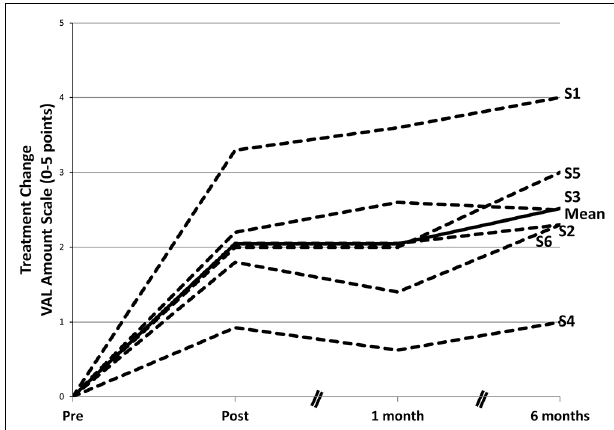
FIGURE 7 | Changes in amount of participation in speech in life situations after a course of CIAT II. The mean gain from pretreatment on theVerbal Activity Log (VAL) amount of use scale was significant at posttreatment. After treatment, there was an additional significant performance gain. Data in the graph are ipsitized—that is, pretreatment scores are set to 0 for each participant, and subsequent scores are reported as changes from pretreatment. S1–S6 refer to subject numbers. Modified from Johnson etal.